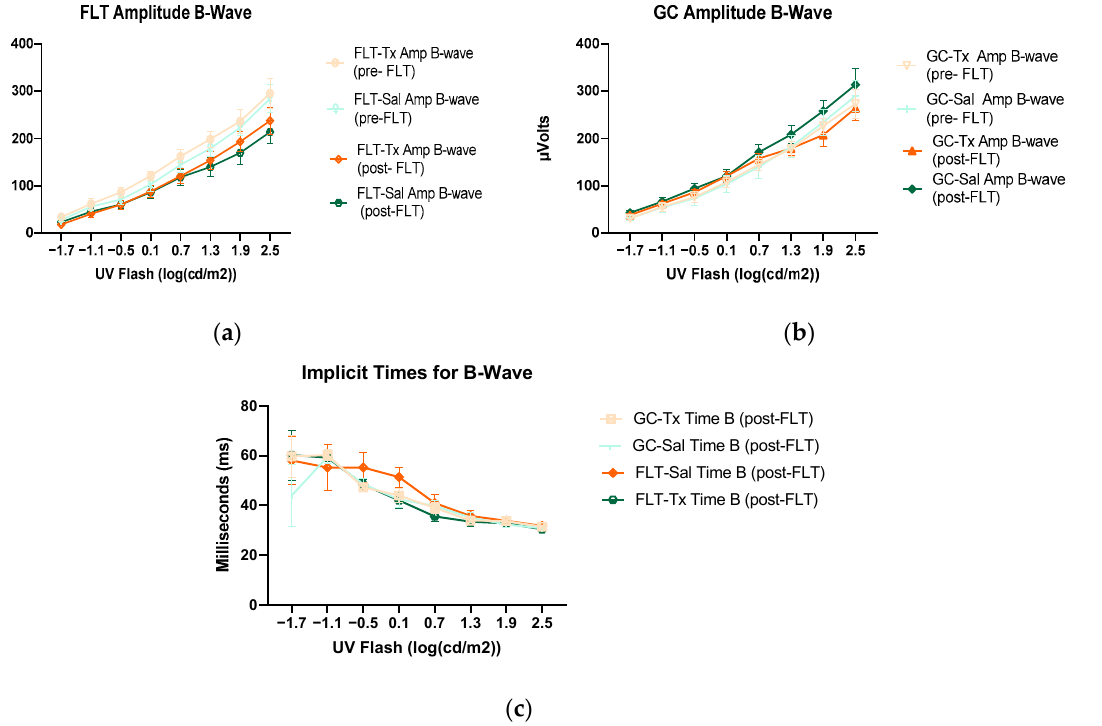
Figure 5. Electroretinography (ERG) b-waves of ( a ) changes in the amplitudes of pre- and post-flight flight (FLT) groups. ( b ) Changes in the amplitudes of pre- and post-flight ground control (GC) groups in response to increasing flash intensities. ( c ) Changes in the implicit time of post-flight FLT and GC groups. Each point represents the mean ± SEM (n = 8). Note that the response is lower with increased flash intensity in the post-flight group compared to the pre-flight response. The response is similar between pre- and post-GC measurements.